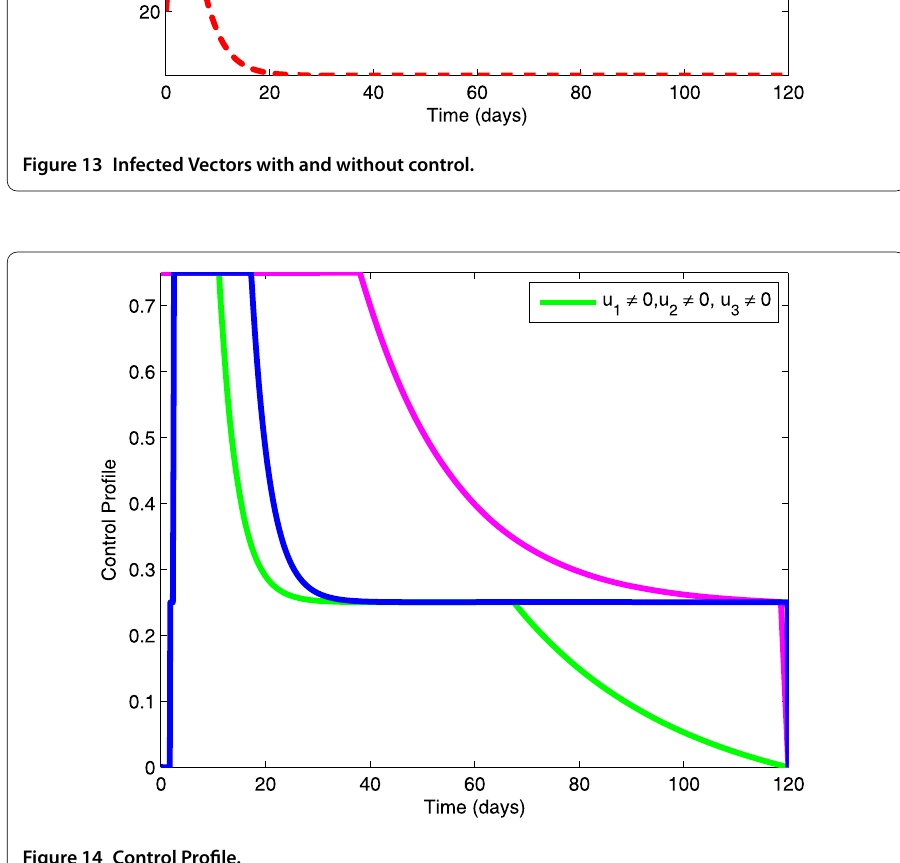
Figure 14 Control